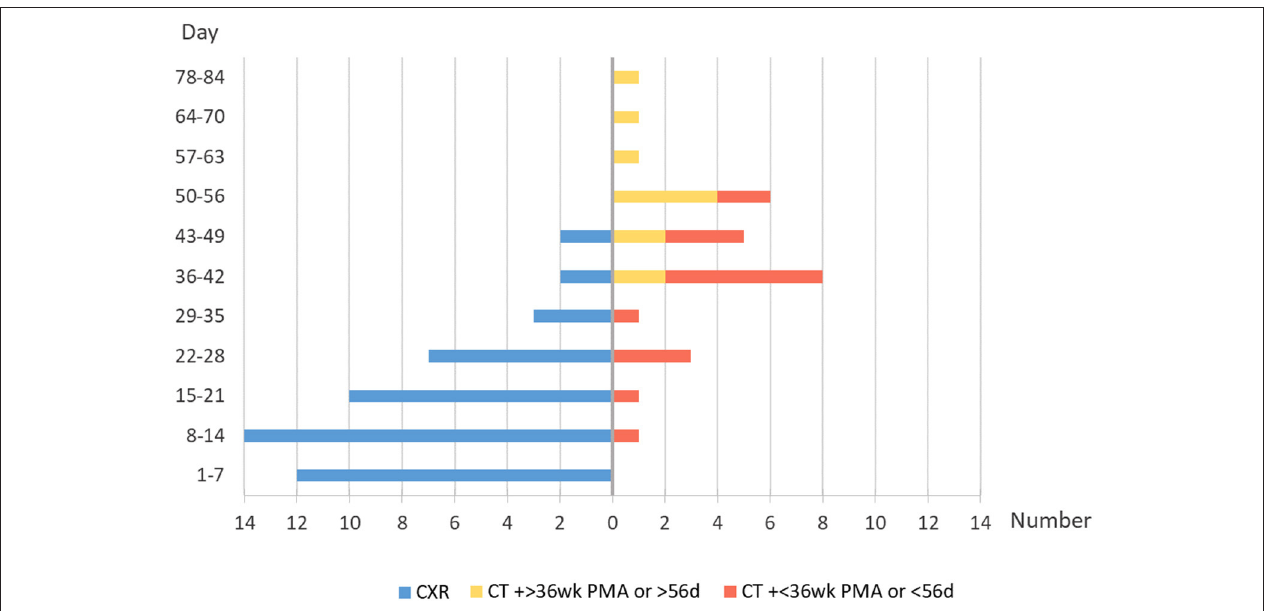
FIGURE 3 | Timing and modalities of the typical imaging appearance first showed.